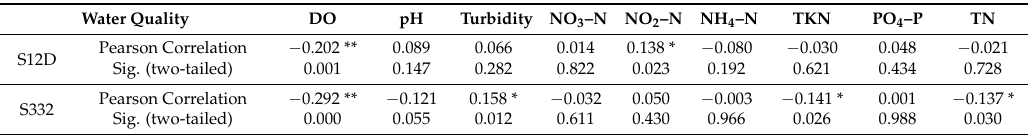
Pearson Correlation −0.292 ** −0.121